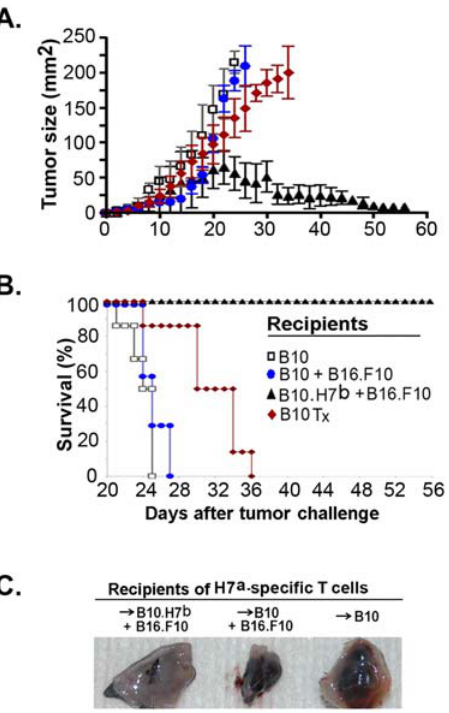
Figure 5. Challenge of long-term chimeras with melanoma cells. We studied mice from the four experimental groups described in Fig. 4. On day 100, mice were challenged with 2 6 10 5 B16.F10 melanoma cells s.c. A) Tumor surface area and B) survival of experimental groups (n $ 10 mice per group). The mean survival times for the following groups were significantly different: white vs. black, white vs. red, and blue vs. black, P , 0.0001; red vs. black, P , 0.001. C) Examination of excised tumor injection site shows large tumor nodules (black) in B10 mice but only an inconspicuous micro-nodule in the B10.H7 b mouse (one representative experiment out of 10). Tx, thymectomized. doi:10.1371/journal.pone.0004116.g005 host cells. H7 a -specific memory T cells were abundant in euthymic